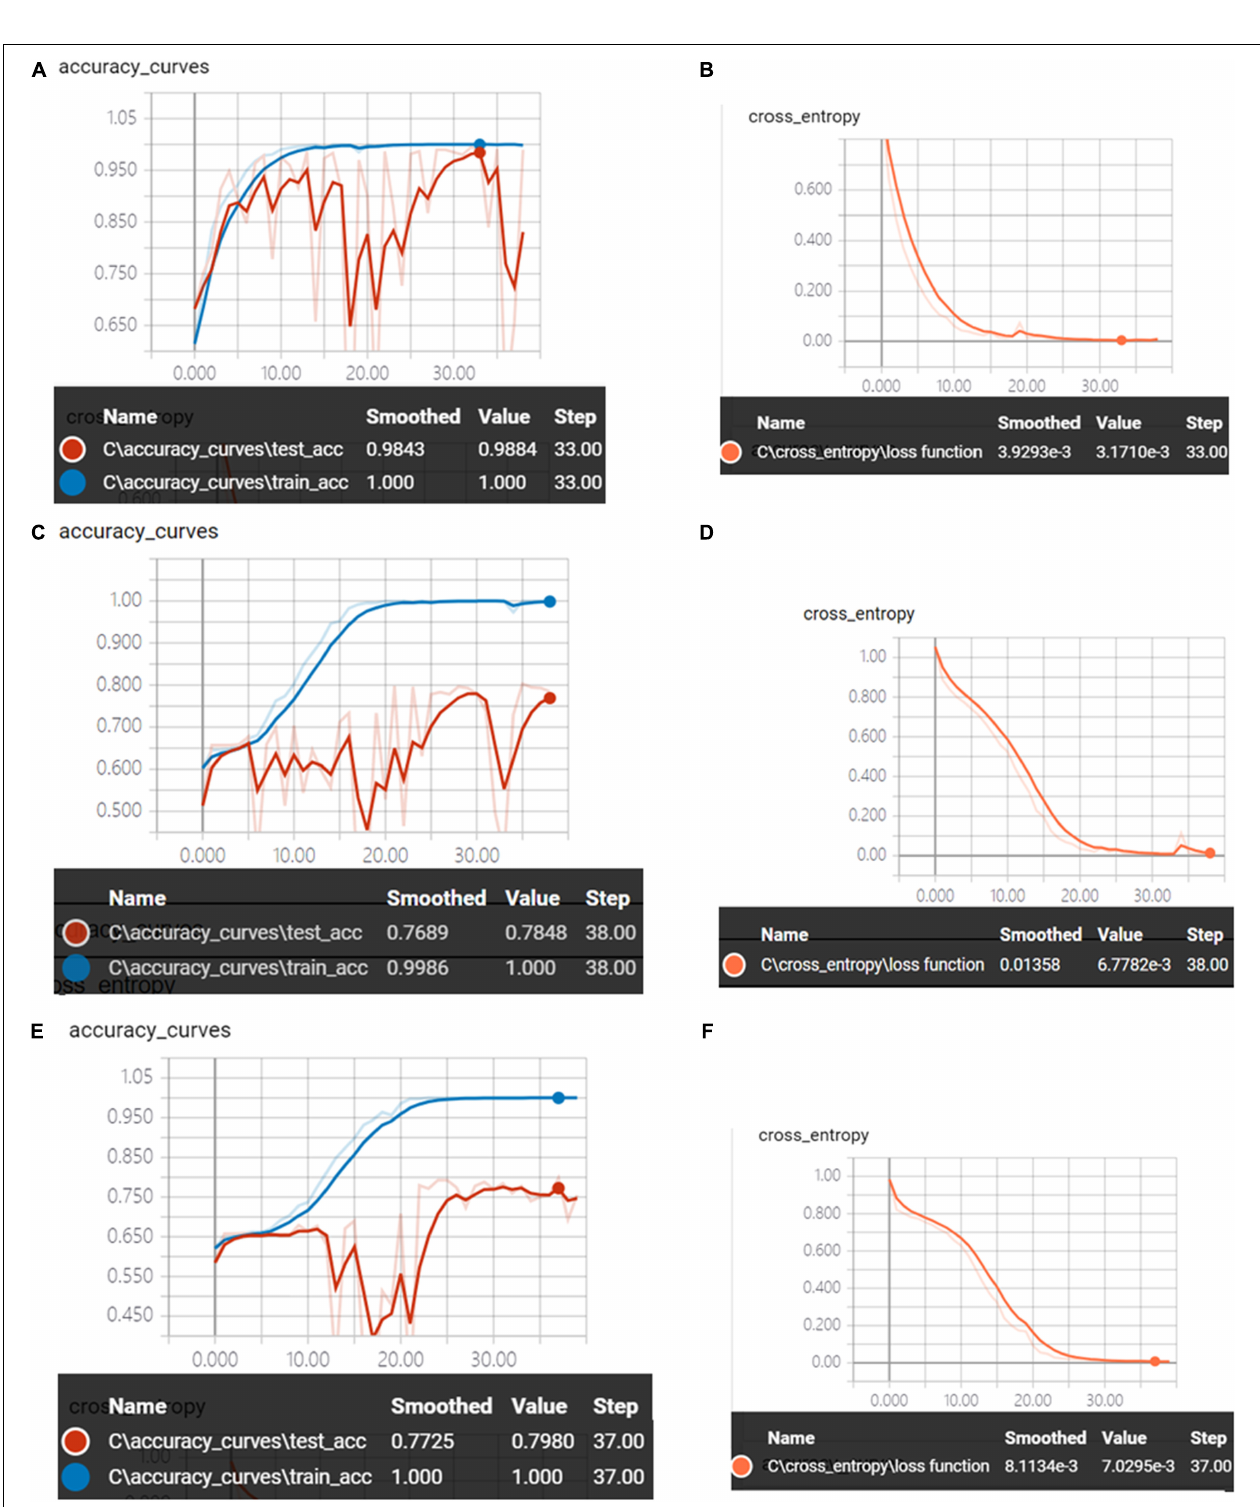
FIGURE 9 | (A) The accuracy curves of synchronous 2DCOS spectra on 1,450–1,000-cm − 1 band. (B) The cross-entropy cost function of synchronous 2DCOS spectra on the 1,450–1,000-cm − 1 band. (C) The accuracy curves of asynchronous 2DCOS spectra on the 1,450–1,000-cm − 1 band. (D) The cross-entropy cost function of asynchronous 2DCOS spectra on the 1,450–1,000-cm − 1 band. (E) The accuracy curves of i2DCOS spectra on the 1,450–1,000-cm − 1 band. (F) The cross-entropy cost function of i2DCOS spectra on the 1,450–1,000-cm − 1 band.